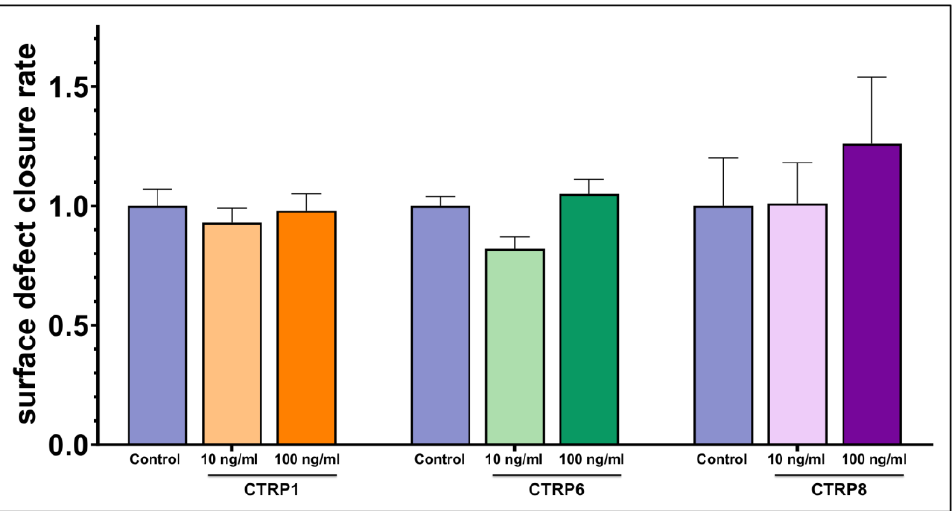
Figure 7. Scratch assays show the dose-dependent impact of CTRP1, CTRP6, and CTRP8 on surface defect closure in human conjunctival epithelial cells (HCjE). Fold-increase in the surface de- fect closure rate. Bars represent mean ± SEM. Analog to HCE, scratch assays were performed on HCjE cell line. Neither stimulation with 10 ng/mL nor 100 ng/mL CTRP1, CTRP6 or CTRP8 did increase the relative surface defect closure rate significantly when compared to the control (one-way ANOVA; p > 0.05).